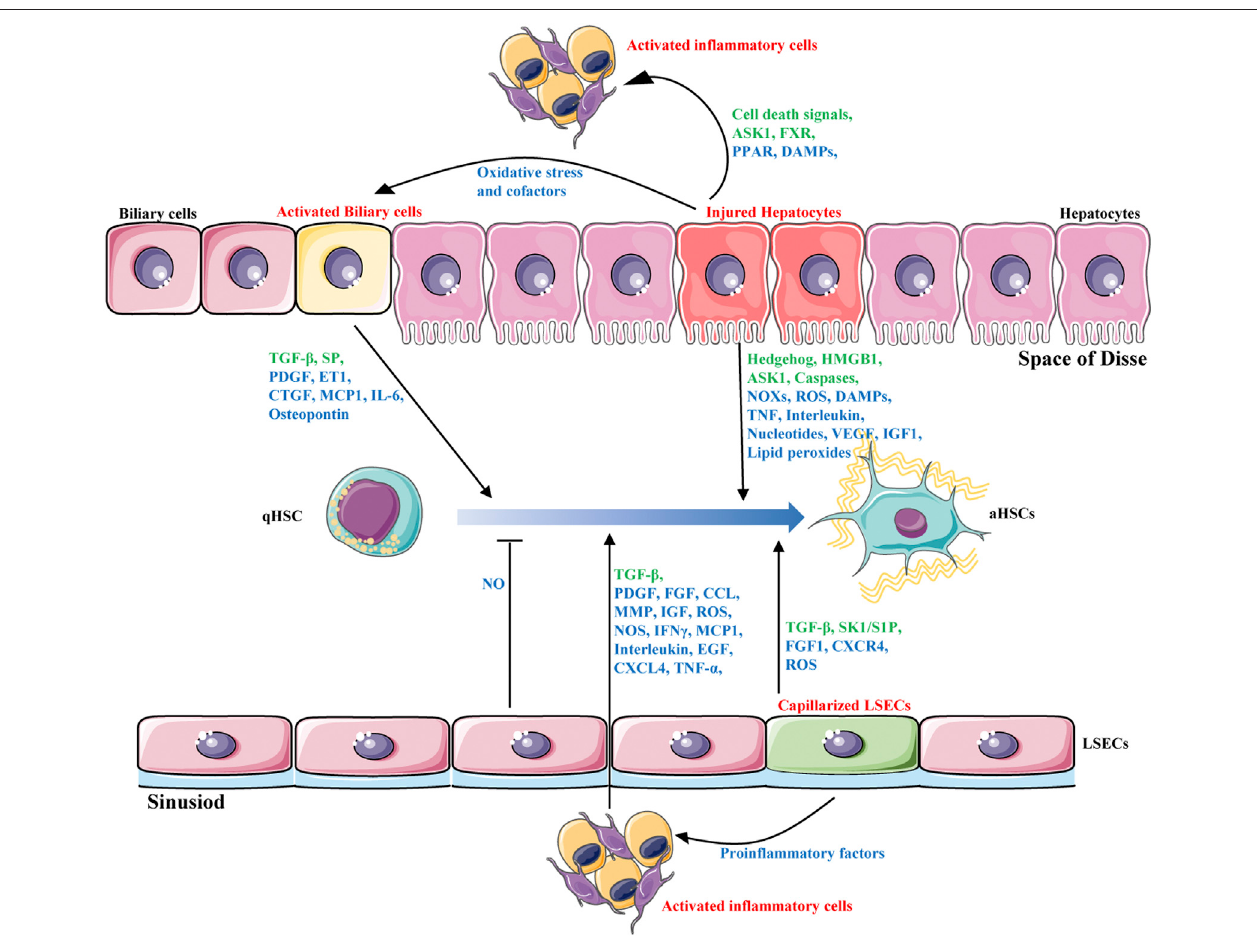
FIGURE 1 | Intercellular crosstalk during liver fi brosis. HSCs activation is the major driver of liver fi brosis that depends on the interaction with other hepatic cells, including hepatocytes, biliary cells, liver sinusoidal endothelial cells and in fl ammatory cells. These cells interact with each other and promote or inhibit the activation of HSCs through production of hormones, cytokines(blue) and other signalling